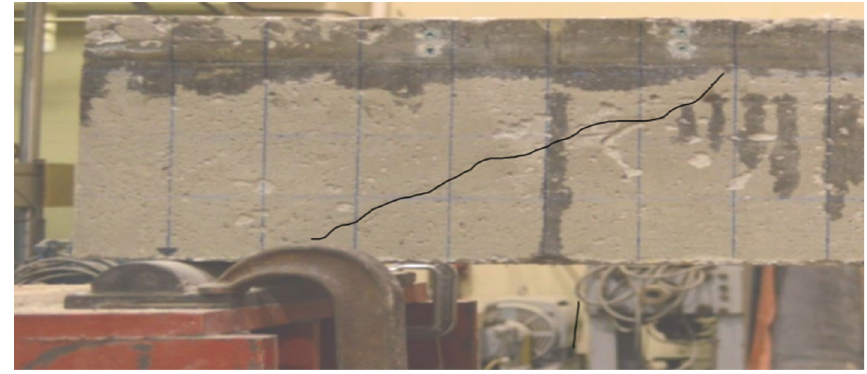
Fig. 17 Shear crack in epoxy repaired